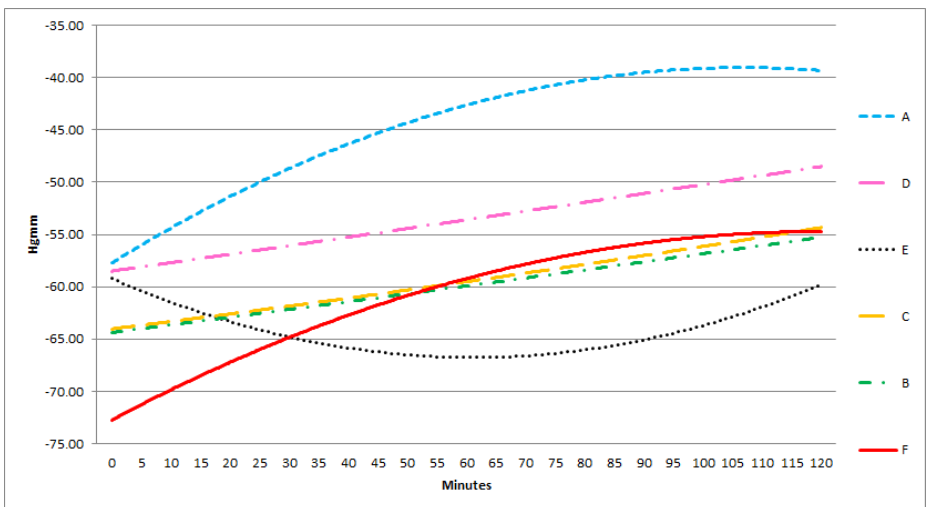
Figure 7. Results of statistical (correlation) analysis between the different sensor pairs during NPWT applying at 100 mmHg suction. The pressure values and their changes in time was measured by different sensors at 100 mmHg NPWT. Sensors represent exact measurement points in the abdominal cavity. (The pressures at sensors A–F are presented enlarged also. A: midline, above the layer; B: midline, under the layer; C: laterally, above the layer; D: laterally, under the layer; E: midline, among the bowels; F: laterally, among the bowels.)